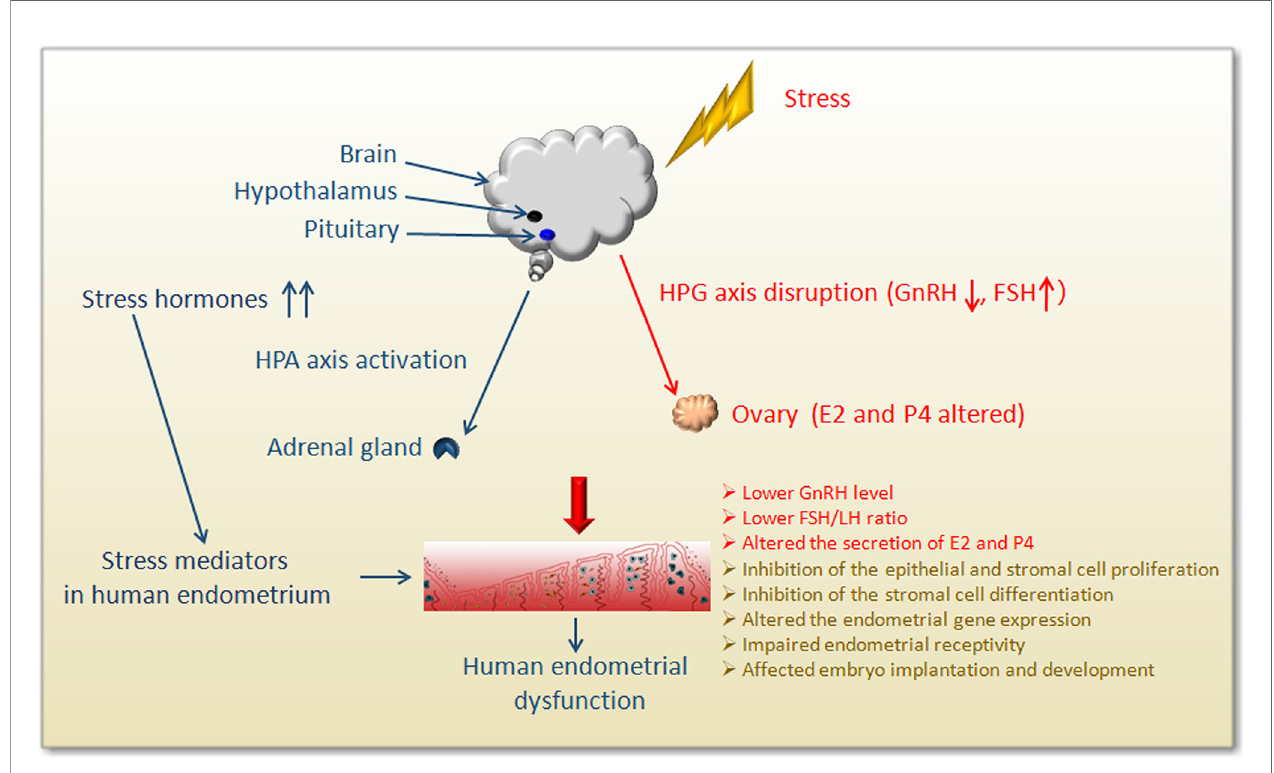
FIGURE 2 | Schematic diagram showing the impact of stress on human